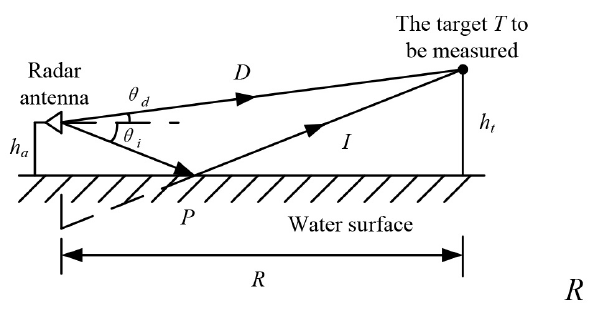
Fig. 1 The multipath wave propagation